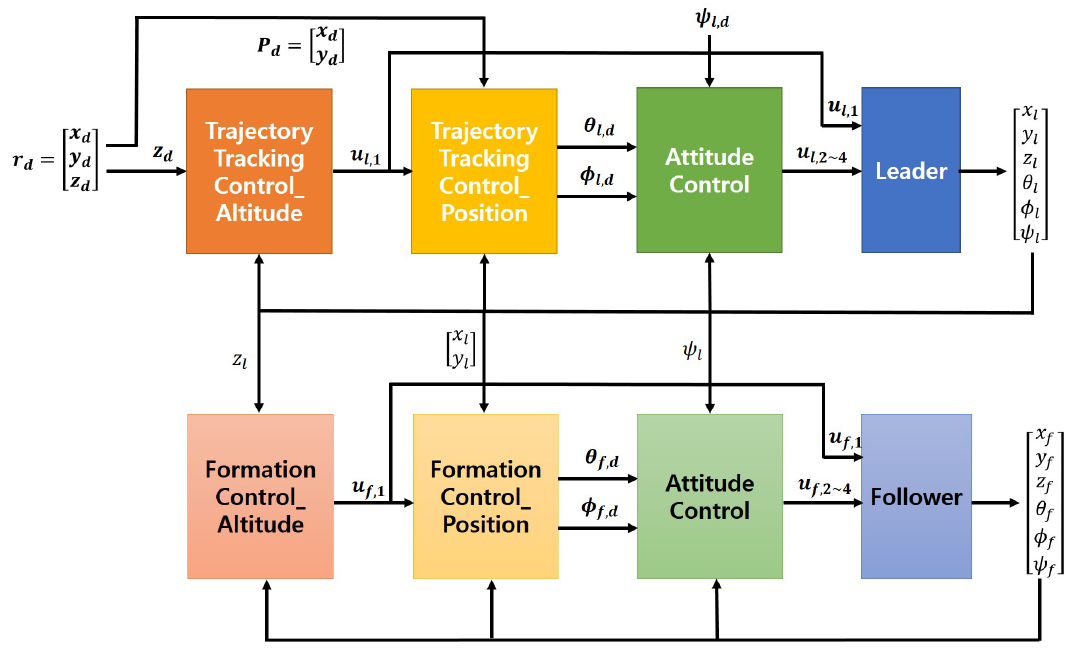
Figure 2. The proposed formation control system block